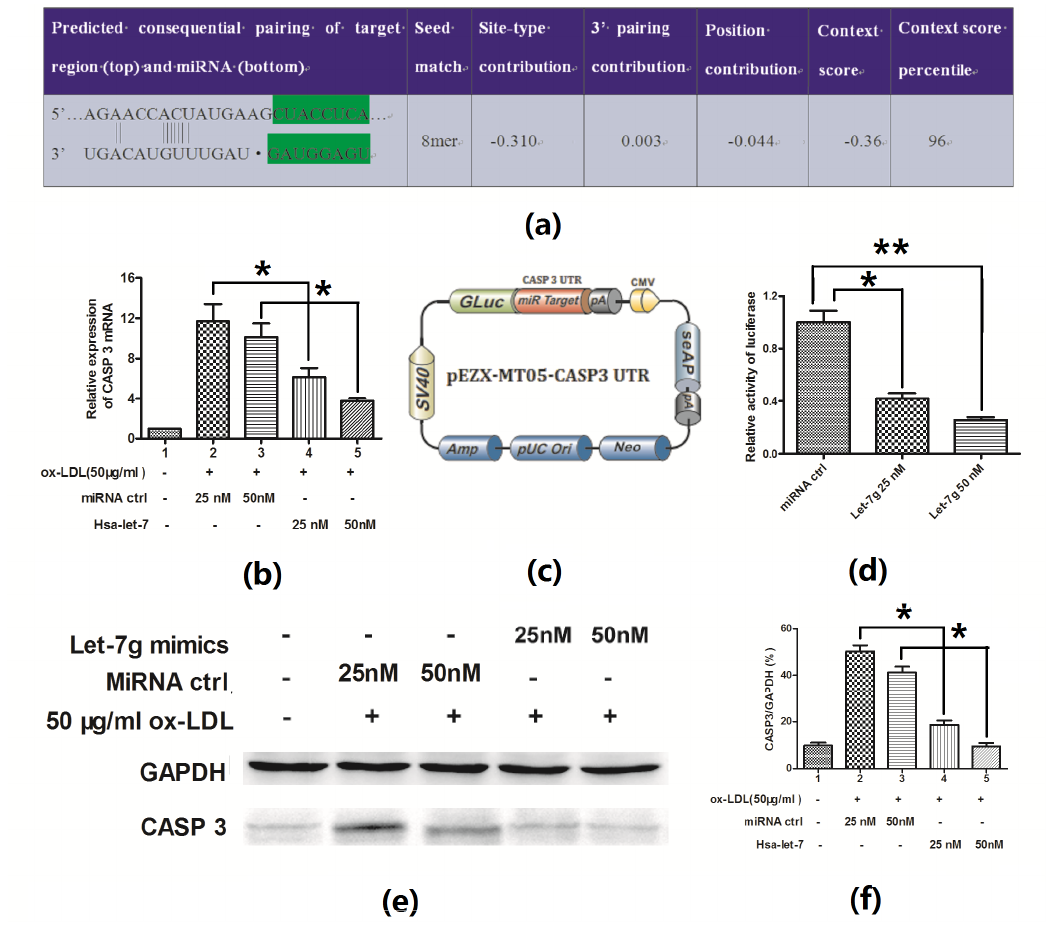
Figure 5. Let-7g targeted on the 3' UTR of CASP3 and decreased the CASP3 expression. ( a ) Hsa-let-7g/CASP3 alignment by the Targetscan analysis; Hsa-let-7g suppressed CASP3 expression in mRNA level ( b ) or protein level ( e ) and ( f ). 24 h post treating with 50 μ g/mL ox-LDL and transfecting with miRNA control or hsa-let-7g, EAhy926 cells were quantitatively determined for the CASP3 expression at mRNA level ( b ) and at protein level ( e , f ), compared to GAPDH. ( c ) Schematic diagram of pEZX-MT05 plasmid with miRNA control or has-let-7g mimics. All results were averaged with three independent experiments. Statistical significance was shown in the figure. * p < 0.05, ** p <